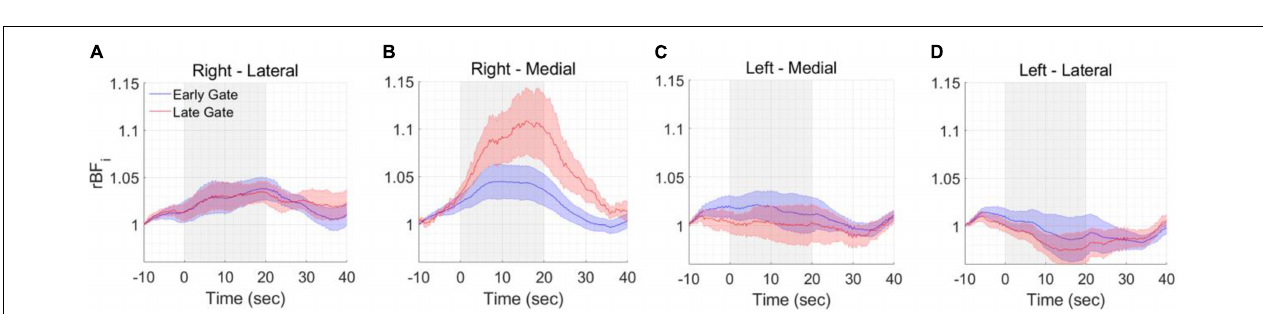
FIGURE 6 | Grand averages of six healthy volunteer test results during pressure modulation and breathing trials. BF i changes during the different tasks were averaged across all included trials and all subjects. The gray shaded areas indicate the periods of pressure modulation (A,B) or breath holding (C,D) . (A) BF i changes during pressure modulation (60 s) at different short SD separation (5 mm, pseudo-CW) and 15 mm SD separation and early and late gates at medial and (B) lateral spatial locations. (C) BF i changes during breath holding (20 s) at 15 mm SD separation and early and late gates at medial and (D) lateral spatial locations. Shading around the lines represents the standard error of the six subjects.